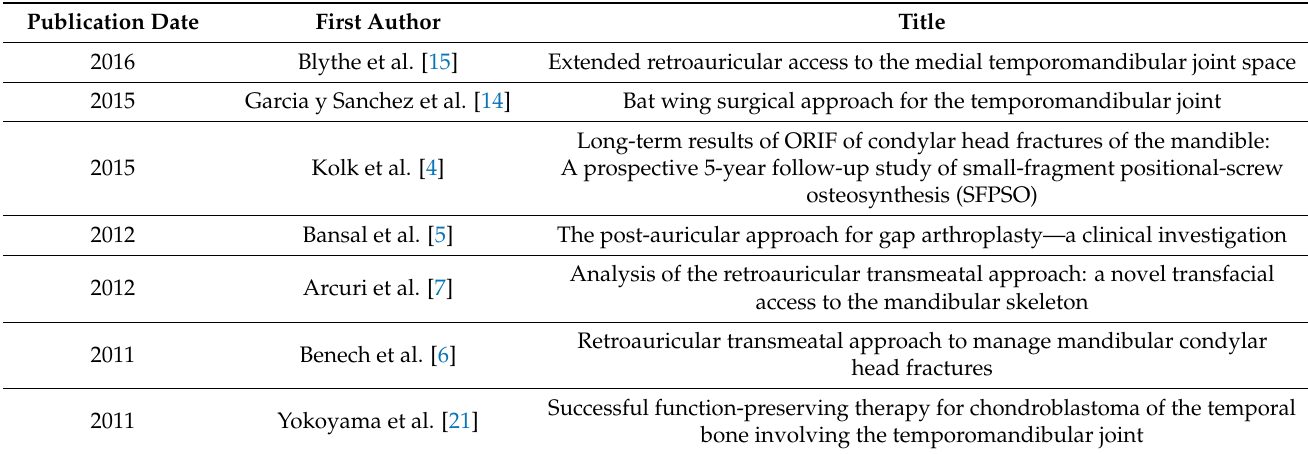
Table 3. Studies included as a result of the systematic review.